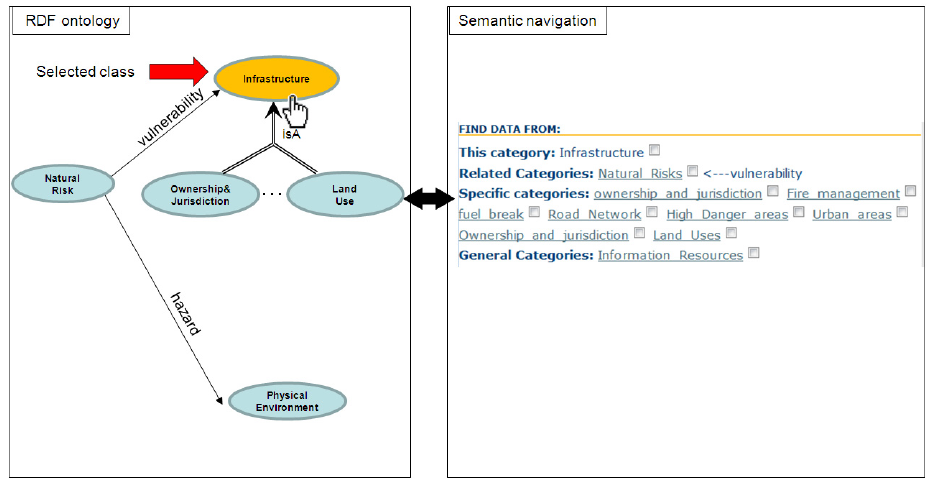
Fig. 9. Exploration of semantic related resources.